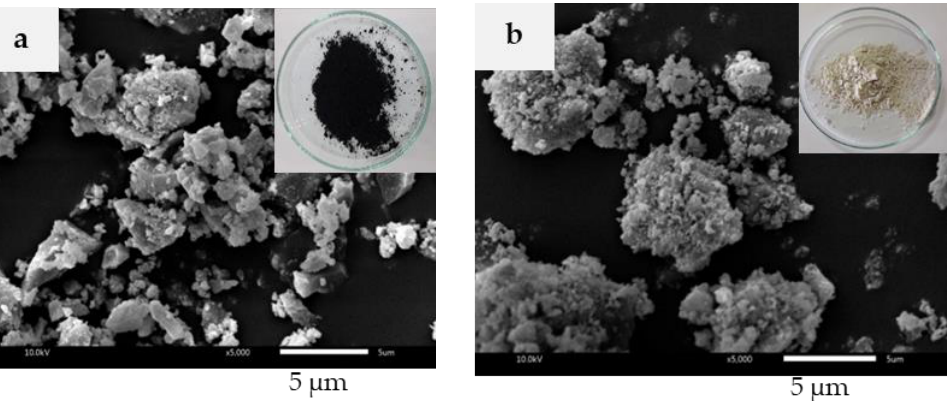
Figure 1. Scanning electron microscope (SEM) images of BRHA ( a ) and WRHA ( b )